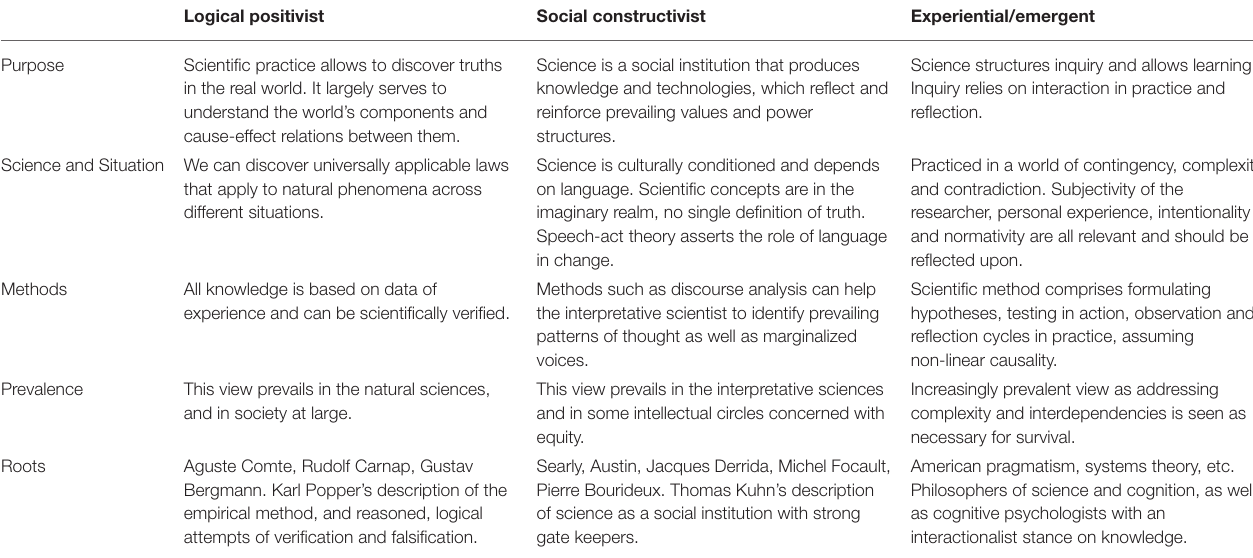
TABLE 1 | Simplified views associated with different ways of practicing